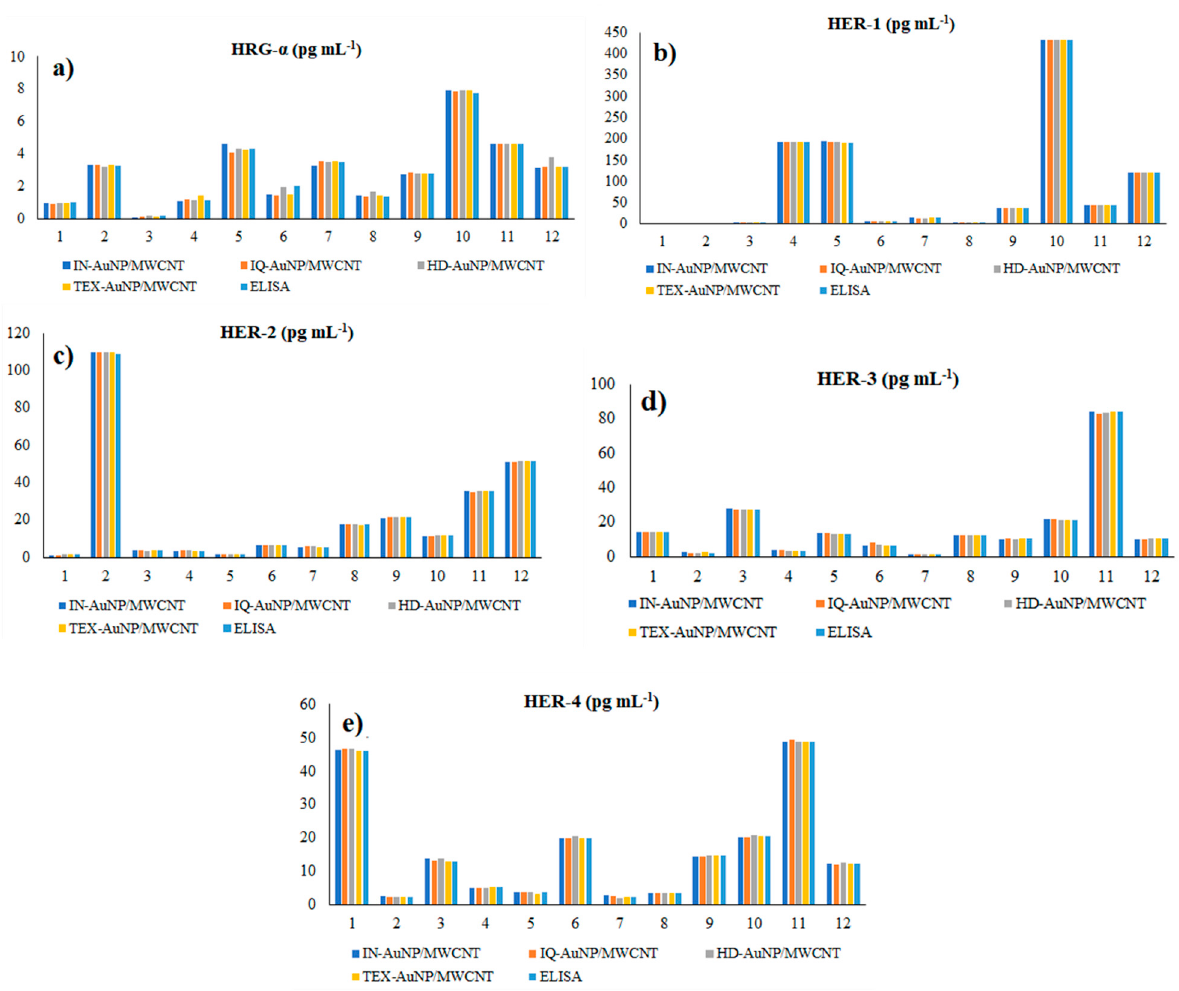
Figure 5. Determination of HRG- α ( a ), HER-1 ( b ), HER-2 ( c ), HER-3 ( d ), and HER-4 ( e ) in whole blood samples, using 3D stochastic microsensors based on IN/AuNP-MWCNT, IQ/AuNP-MWCNT, HD/AuNP-MWCNT, and TEX/AuNP-MWCN, and the gold standard method-ELISA. Table 3. Recovery assays of HRG- α , HER-1, HER-2, HER-3, and HER-4 in biological samples using the 3D microsensors (N = 3).